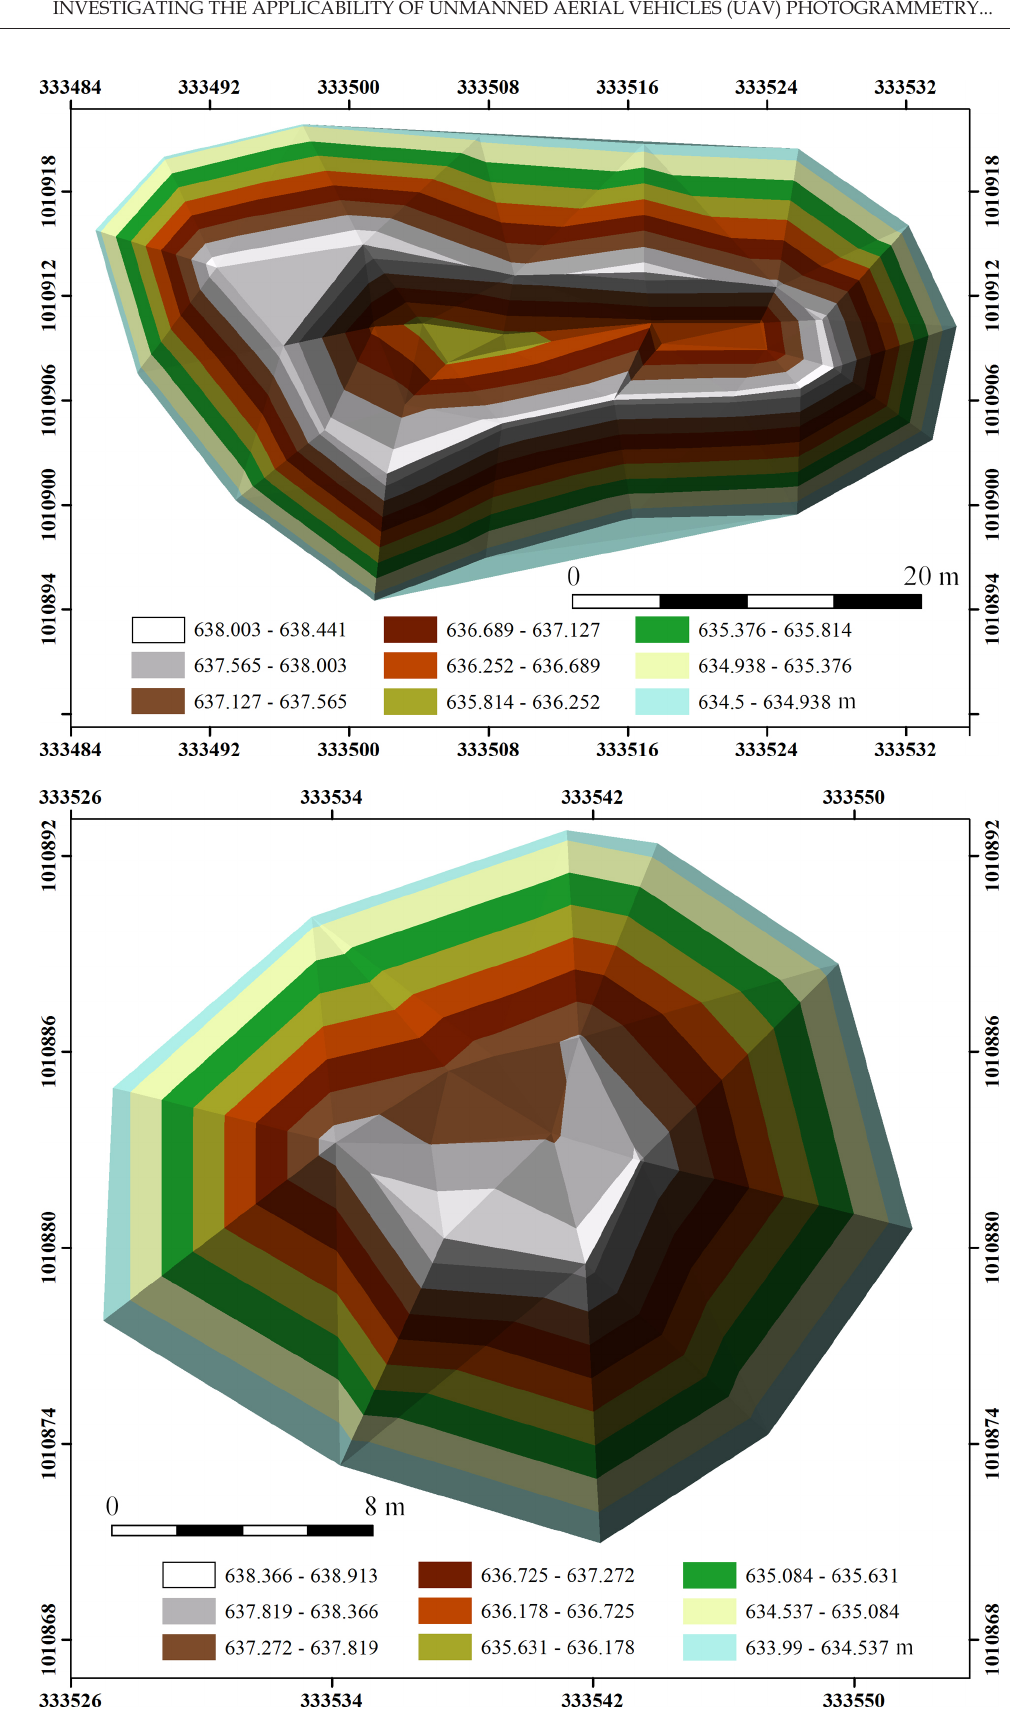
Fig. 5a. TIN model of the stockpiles A and b generated from